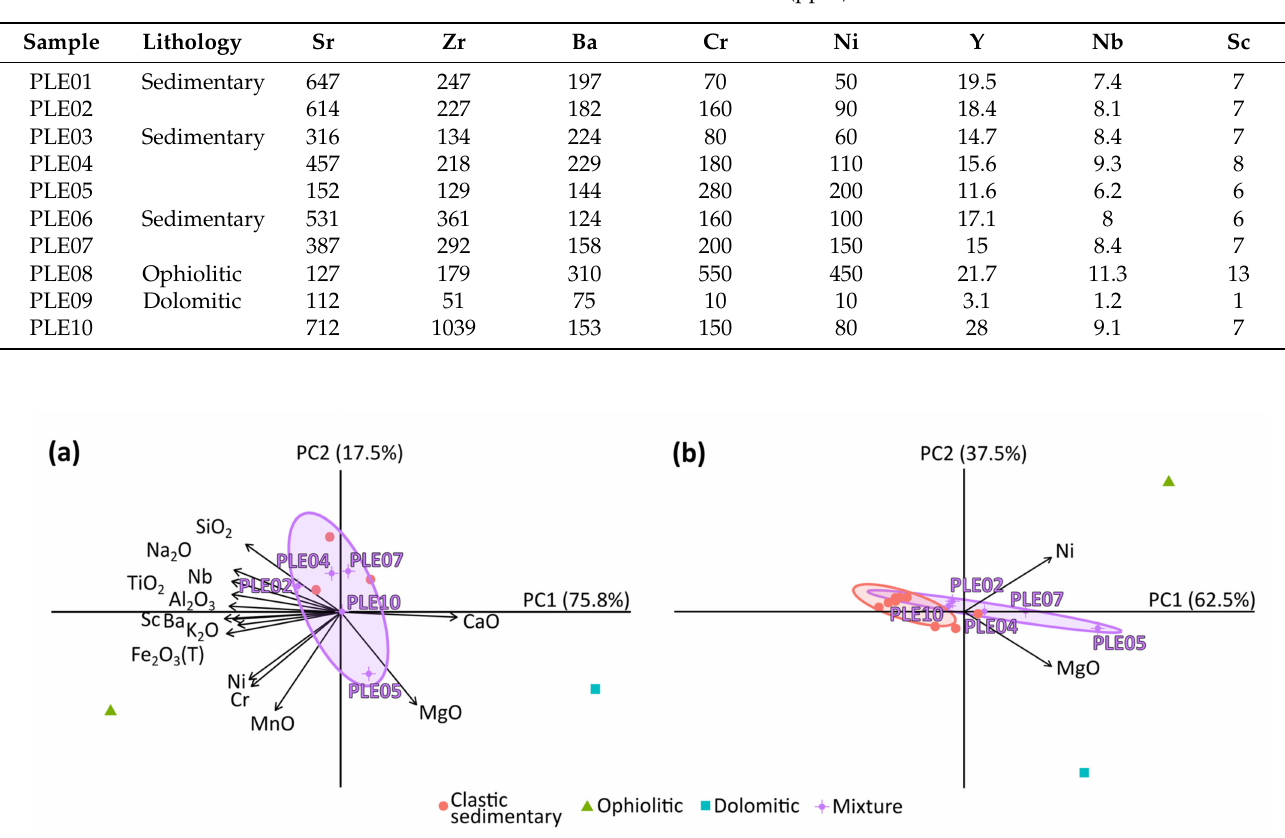
Table 3. Content of trace elements (ppm).